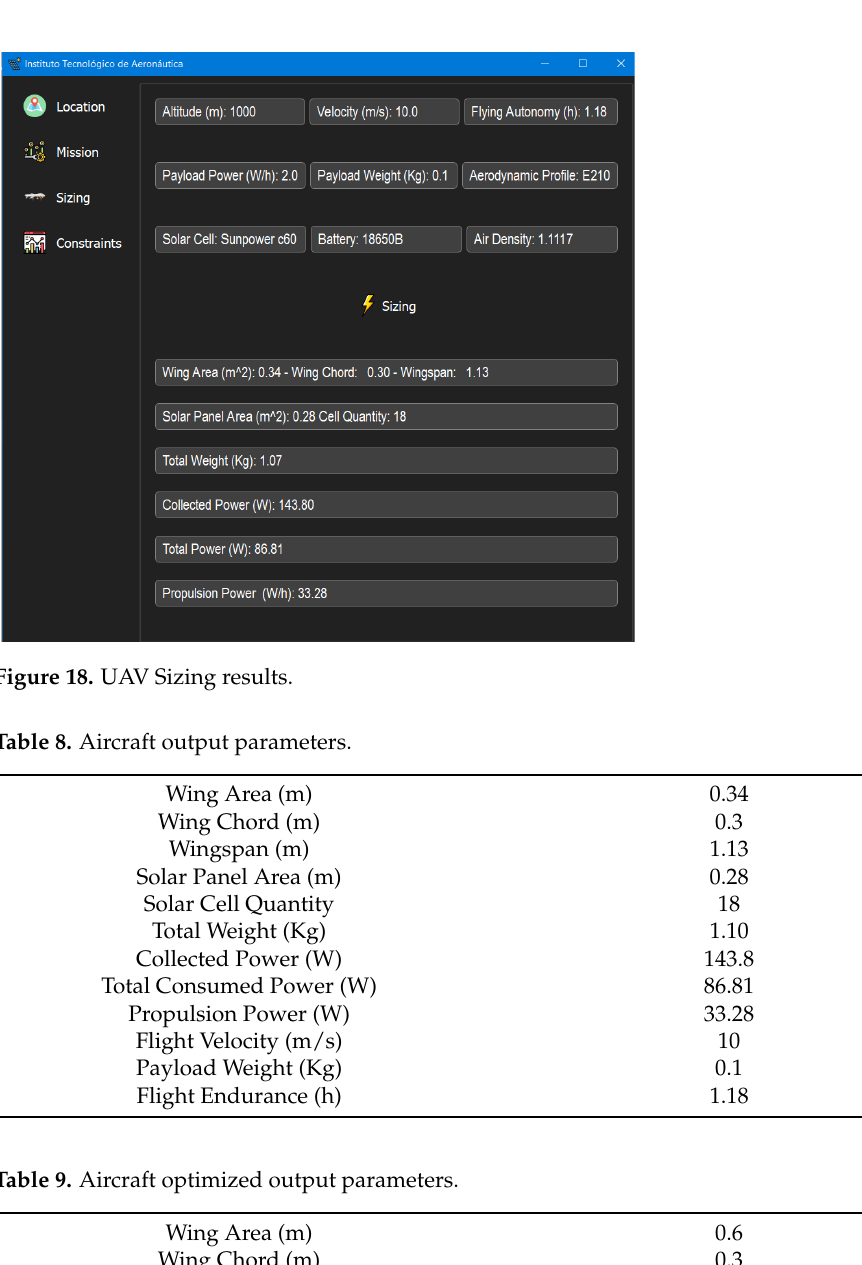
Table 9. Aircraft optimized output parameters.